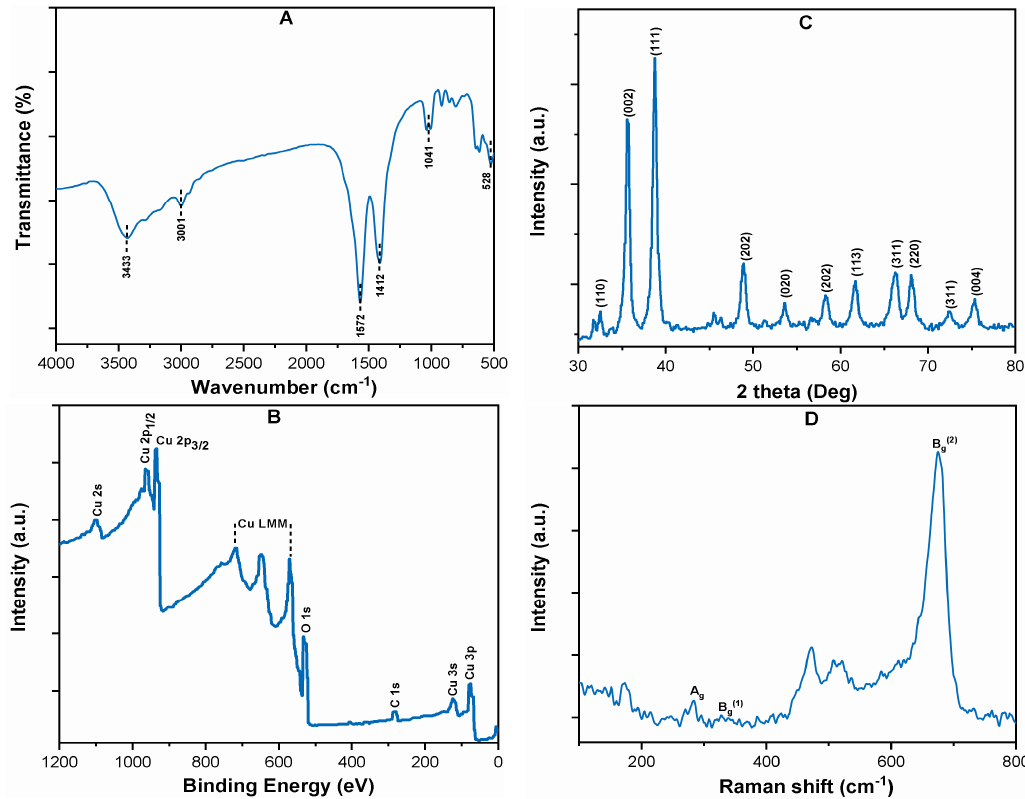
Figure 1. Characterization: ( A ) FT-IR; ( B ) XRD; ( C ) XPS survey spectrum; and ( D ) Raman survey spectrum of CuO powder.